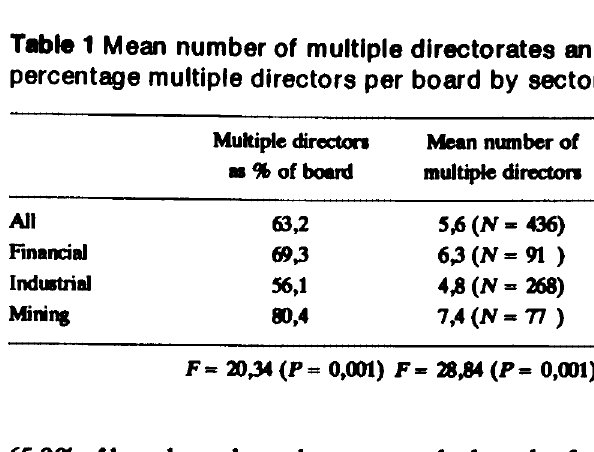
Table 1 Mean number of multiple directorates and percentage multiple directors per board by